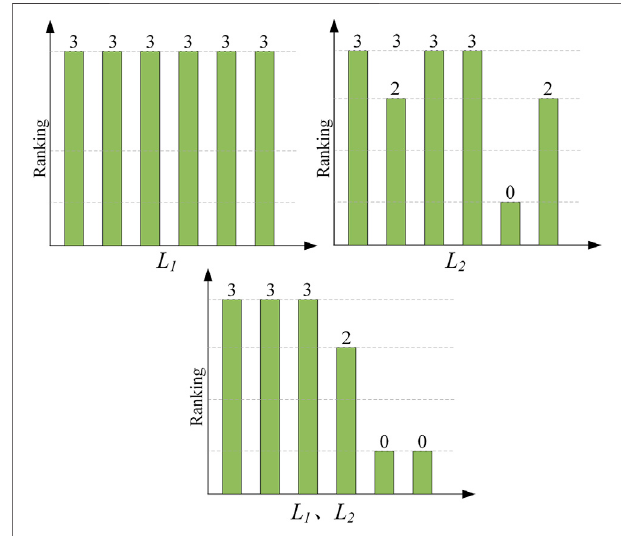
FIGURE 10 | Code diagram of water immersion defect in the horizontal layout of the cable sheath junction box.